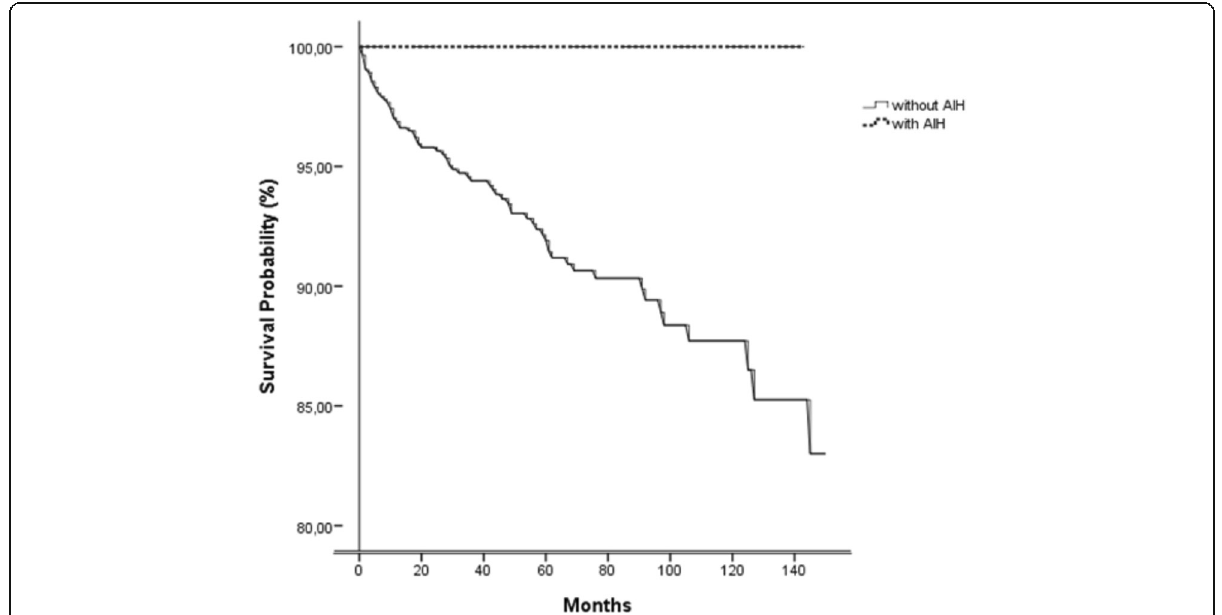
Fig. 1 Kaplan-Meier overall survival curve in childhood-onset systematic lupus erythematosus patients with autoimmune hepatitis (AIH) compared to those without this